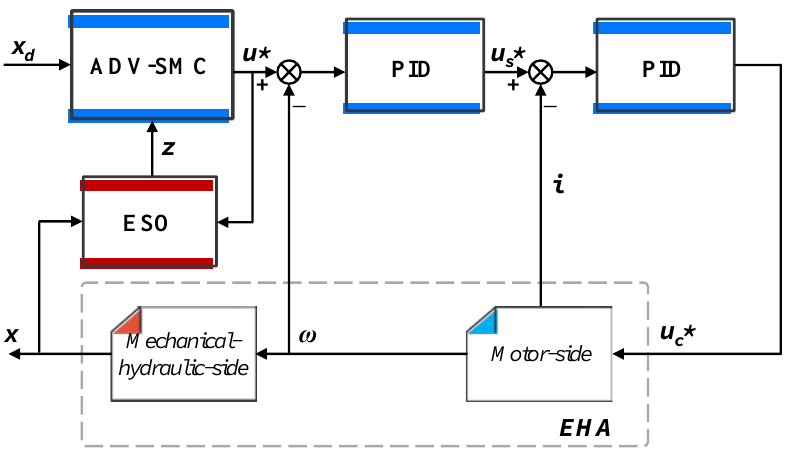
Figure 3. Schematic of proposed cascade controller.